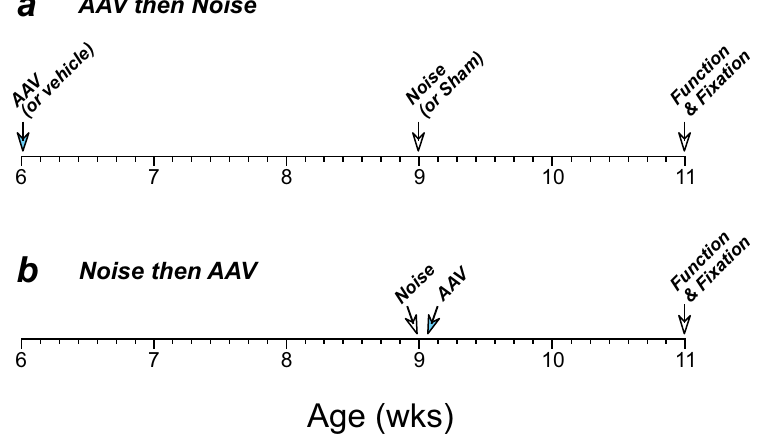
Figure 1. Timelines for the two types of experiments in this study. ( a ) In one protocol, viral suspensions or vehicle were delivered via the PSCC at 6 wks, exposed to noise 3 wks later, allowed to recover for 2 wks, then assessed for cochlear function and/or sacrificed for tissue harvest. ( b ) In the second protocol, animals were exposed to noise at 9 wks, and viral suspensions were delivered via the PSCC within 4.5 hrs post-exposure. Animals recovered for 3 wks, then assessed for cochlear function and sacrificed for tissue